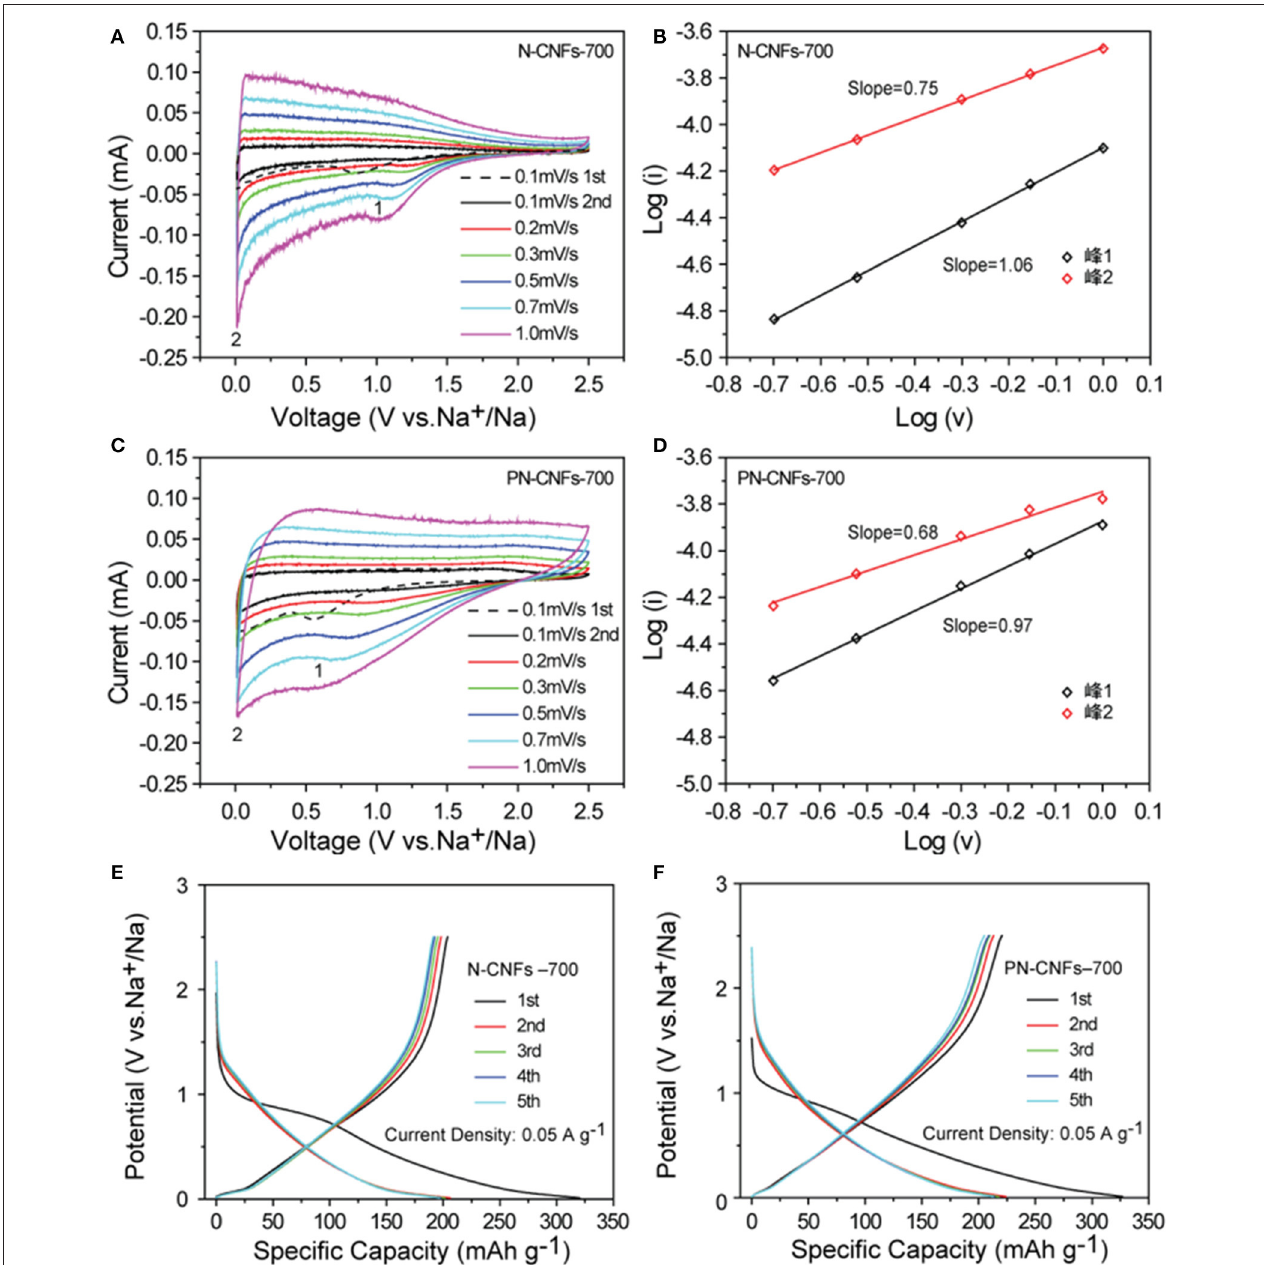
FIGURE 3 | The CV curves of N-CFs-700 (A) and PN-CFs-700 (C) at 0.01 V − 2.5V (vs. Na + /Na) at different scanning rates; The log (i)–log (v) curves of N-CFs-700 (B) and PN-CFs-700 (D) . The initial five cycles of galvanostatic charge-discharge curves of N-CFs-700 (E) and PN-CFs-700 (F) at current density of 0.05A g − 1 with potential range from 0.01 to 2.5V (vs. Na +